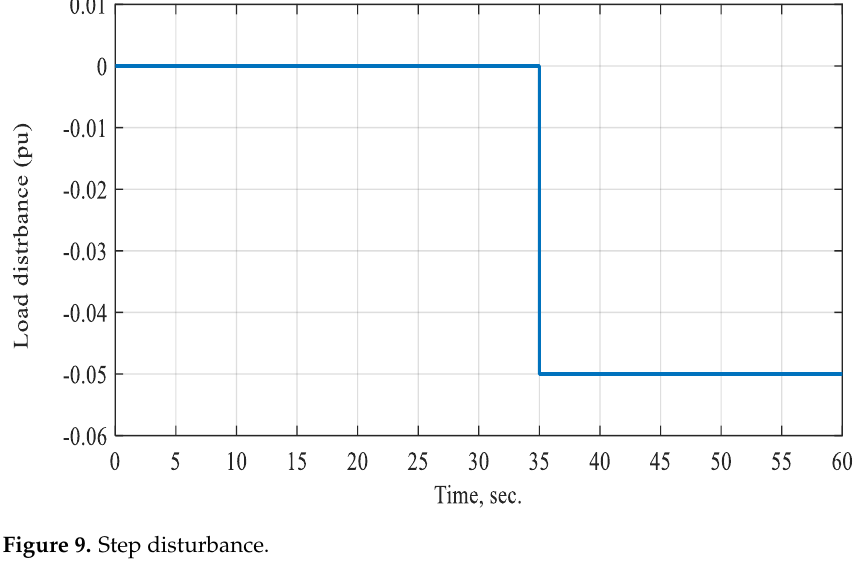
Figure 8. Output gain of EWOA and EWOA + BE.